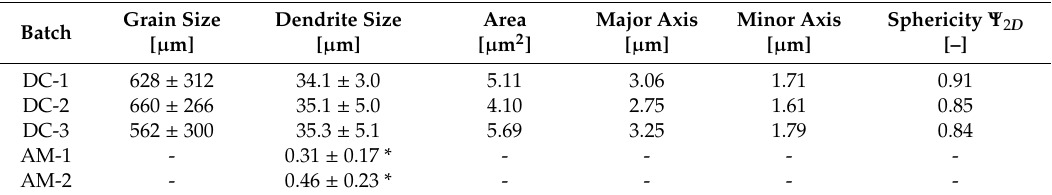
Table 2. Microstructural characteristics of die-cast (DC) and additively manufactured (AM) alloy AlSi7Mg0.3 and